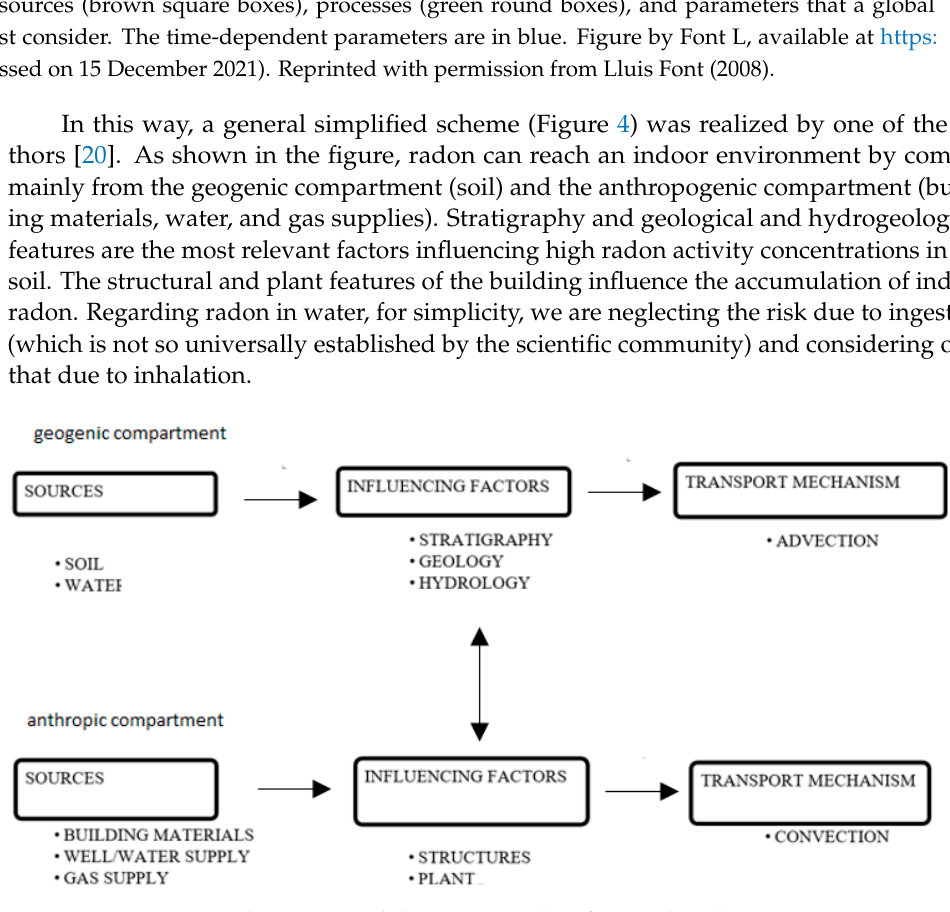
Figure 4. Environmental-occupational determinant: identifying risk and categorizing sources.